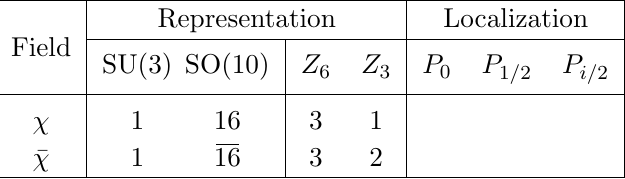
Table 4 . Possible extra messenger-like (cid:12)elds (cid:12)xed on the